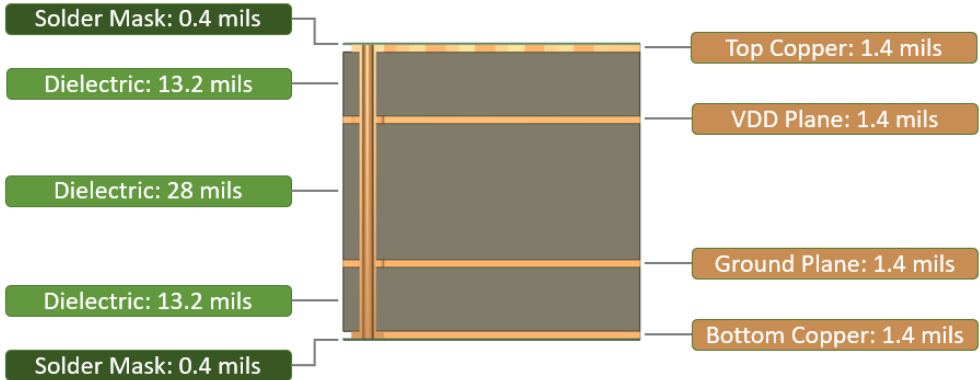
Figure 4. Four-layer PCB stackup including dielectric substrate, copper layers, and solder